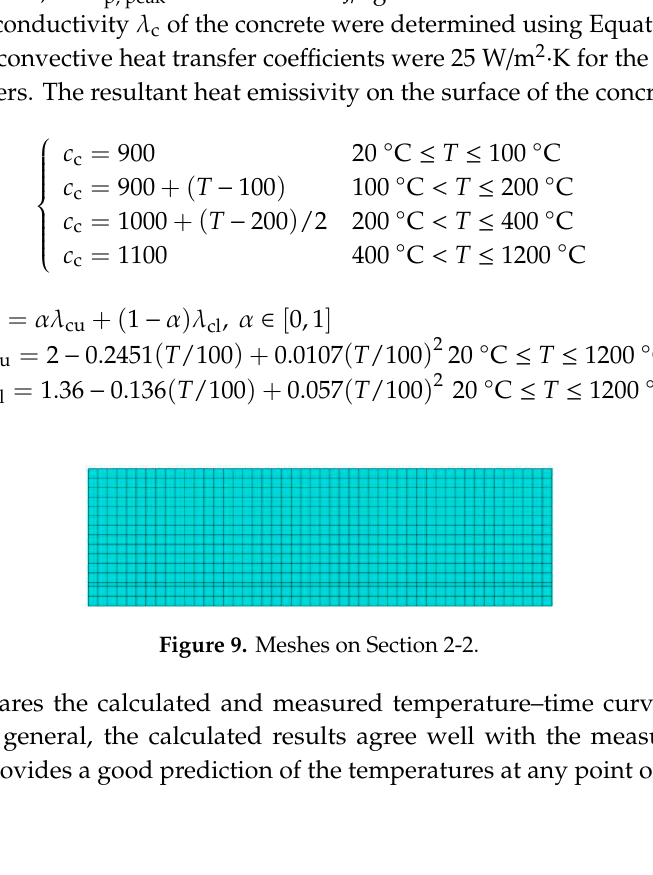
Figure 10. Specific heat of concrete as a function of temperature with different moisture contents.